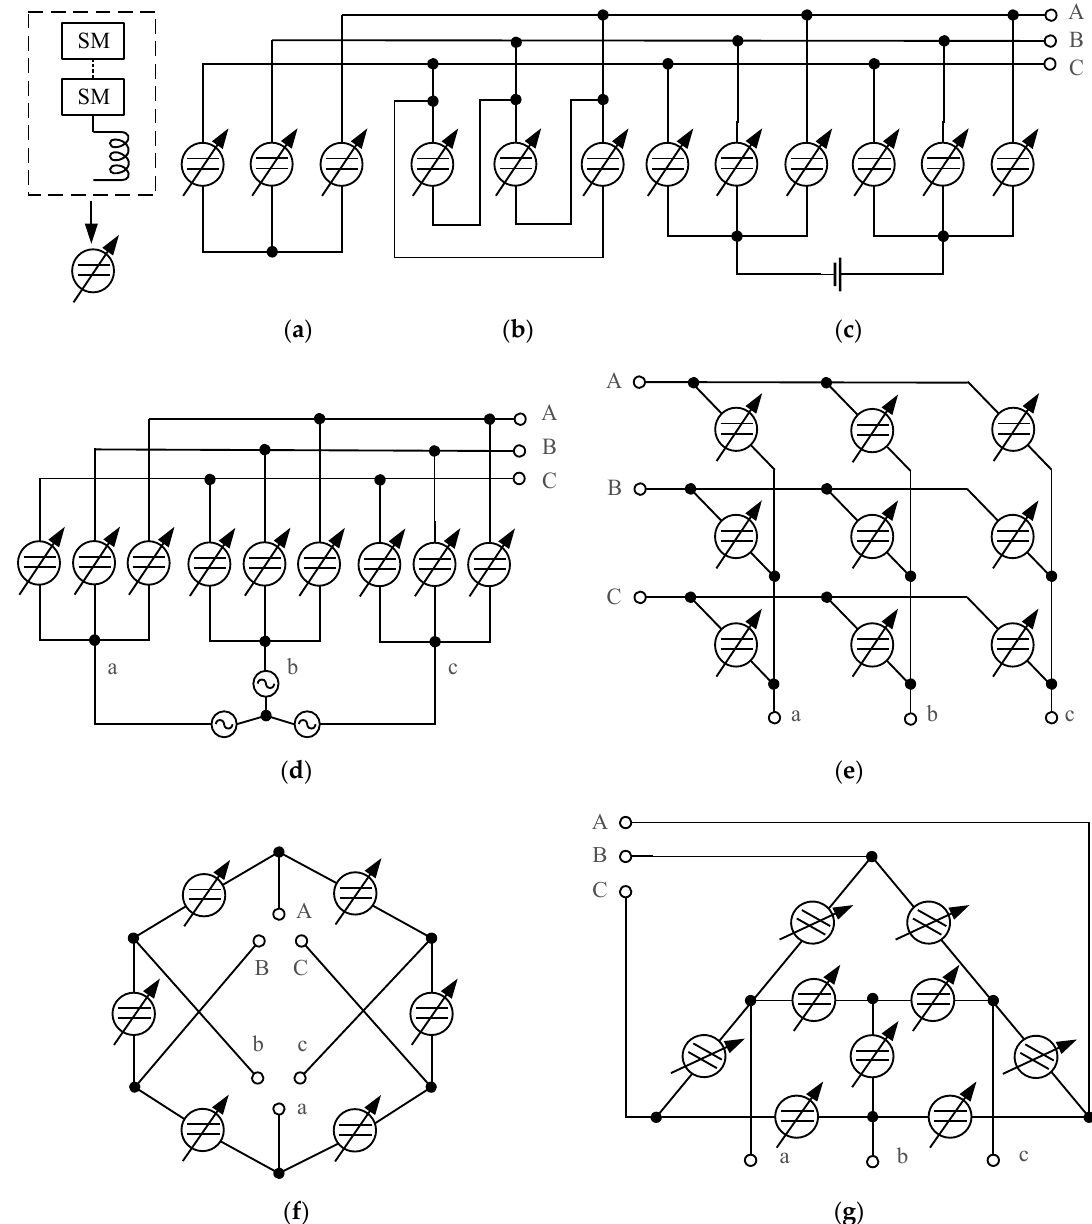
Figure 5. MMC arm configurations: ( a ) Single-star MMC; ( b ) Single-delta MMC; ( c ) Double-star MMC; ( d ) Triple-star MMC; ( e ) M3C; ( f ) Hexverter; ( g ) Hex-Y;.